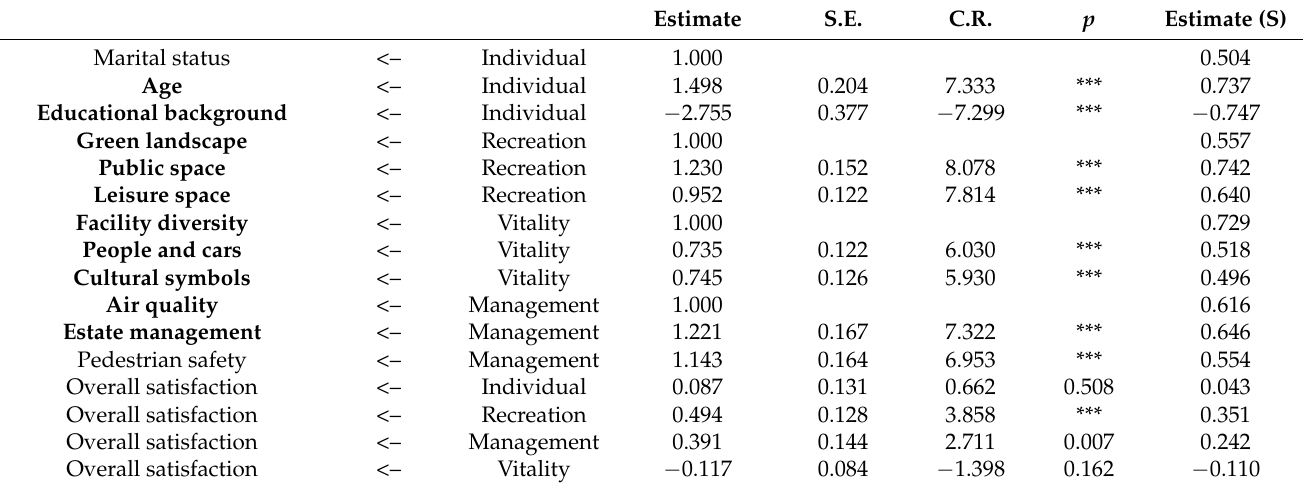
Table 9. Modified SEM coefficient results for